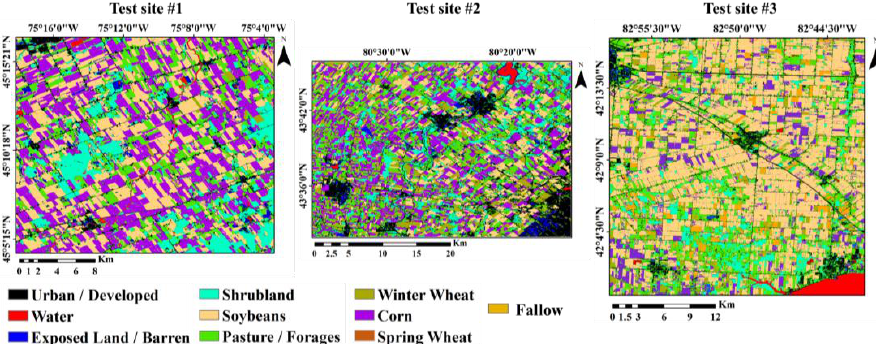
Figure 4. Final land crop/cover maps for the test sites 1, 2, and 3 based on voting scenario. The uncertainty of the results obtained from the land crop classification was deter- mined using the agreement principle (Figure 5). The lower the agreement between the different scenarios in determining the class of an area, the greater the uncertainty (orange areas), and the higher degree of agreement indicates less uncertainty at the pixel scale (blue areas). The average uncertainty in test sites 1, 2, and 3, based on the voting strategy, was 12, 16, and 21%, respectively. The highest and lowest uncertainties were for test sites 3 and 1, respectively; 5, 12 and 15% of the area of test sites 1, 2, and 3 had higher than 60% uncertainty, respectively. A high percentage of high uncertainty areas were related to the border areas between different farms. Therefore, on the uncertainty maps, the patterns were linear and within the farms, and the uncertainty was lower than the border areas. The percentage of uncertainty in agricultural fields was lower than areas with other uses such as urban, barren soil, and pastures.